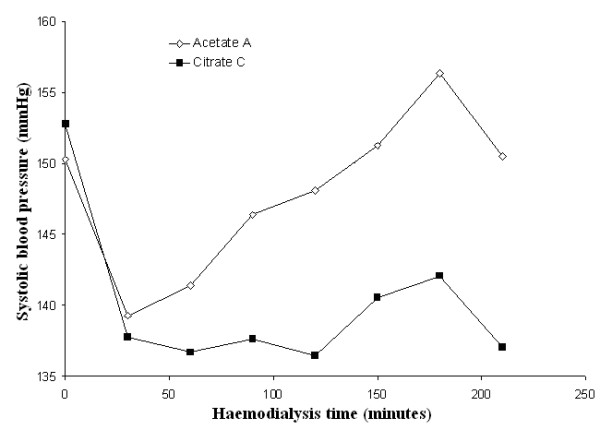
Systolic blood pressure in hypertensive patients. Systolic blood pressure as a function of the haemodialysis time using, respectively, acetate (A) (empty diamonds) and calcium uncorrected citrate (C) (black squares) dialysate in the subgroup of patients with an intradialytic systolic blood pressure increase during dialysis of more than 15 mmHg and at least one value of more than 150 mmHg (n = 8).